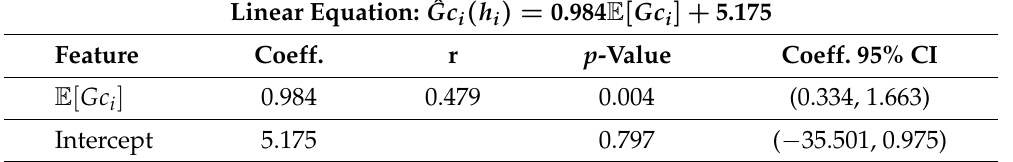
Table 16. OLS regression summary—random student’s Grades against Collaboration group’s Grade